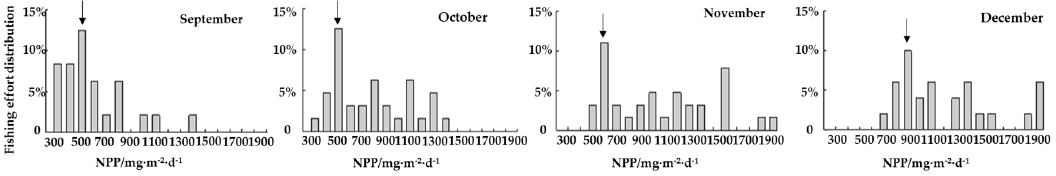
Figure 4. Relationship between the percentage of operation times and NPP in the fishing grounds of the Beibu Gulf from September to December.